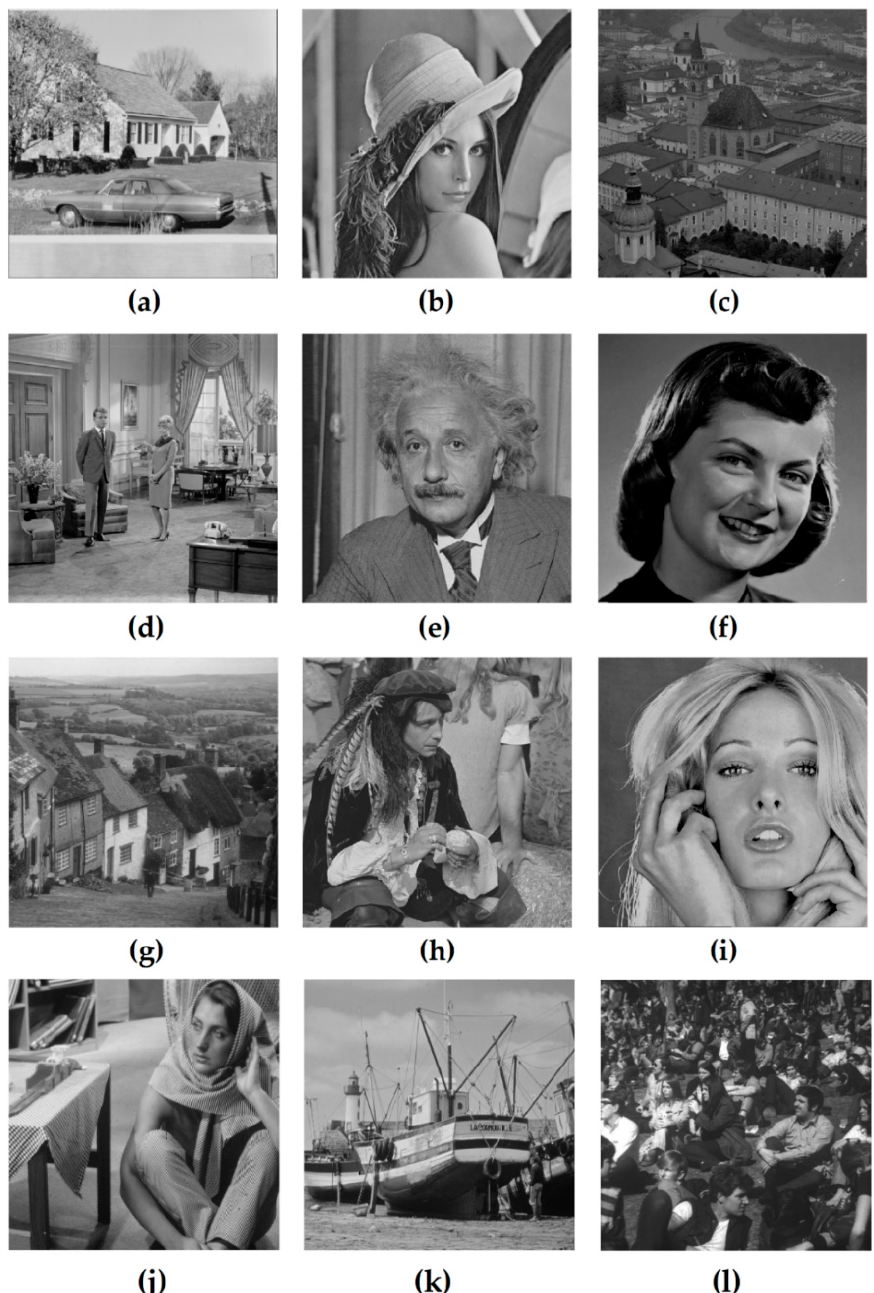
Figure 4. The test images: ( a ) Car, ( b ) Lena, ( c ) Town, ( d ) Couple, ( e ) Einstein, ( f ) Girlface, ( g ) Goldhill, ( h ) Pirate, ( i ) Blonde woman, ( j ) Barbara, ( k ) Boat, and ( l ) Crowd. In order to simplify the reporting of the results, abbreviations are used to identify a specific noise level estimation algorithm and the choice of block size. The abbreviation “SVD Image” denotes the image-based noise level estimation algorithm in Reference [35]. The proposed artificial neural network-based noise level estimation algorithm and the block-based algorithm in Reference [36] are abbreviated as “ANN” and “SVD”, respectively. In each case, after the abbreviation, a number is followed to indicate the choice of block size. Thus, the abbreviation “ANN 32” identifies the implementation of the proposed noise level estimation based on 32 × 32 blocks. The MSE and the average estimation error results across the selected test images and simulation trials are presented in Figure